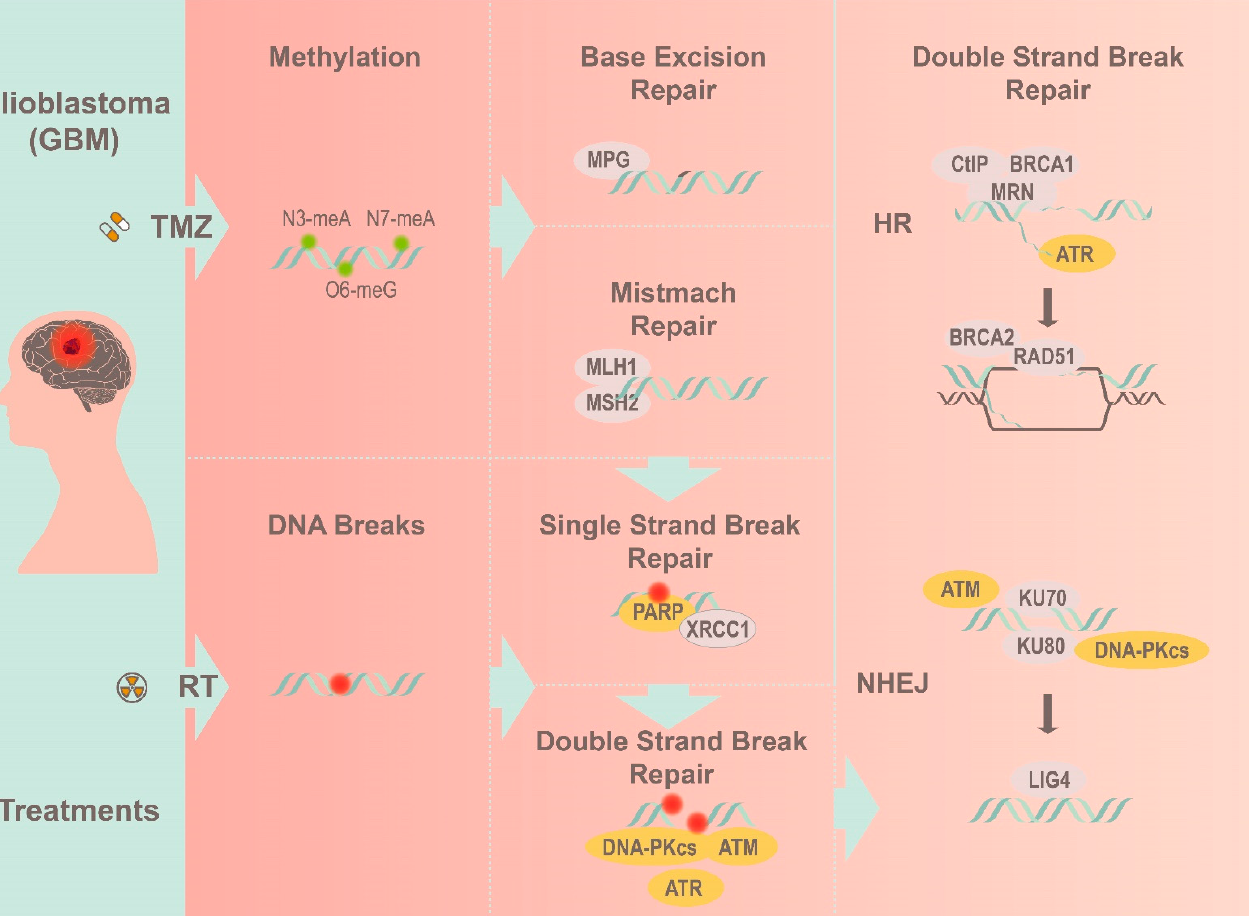
Figure 1. A simplified view of how GBM overcomes radiotherapy and TMZ treatment by utilizing the corresponding DNA repair pathways to resolve different DNA lesions.